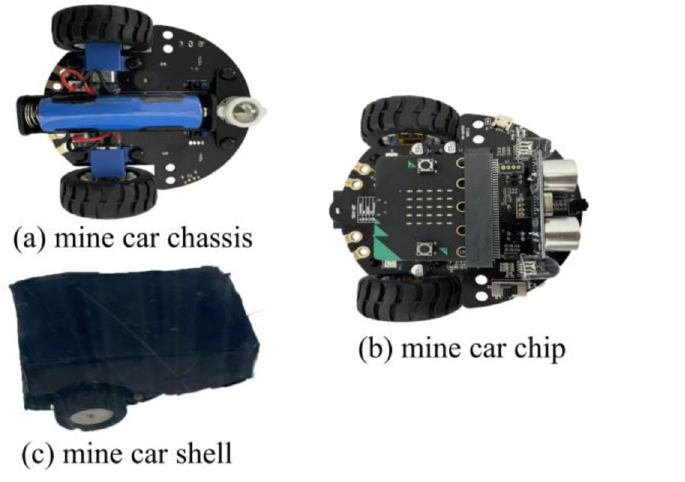
Fig 8. Detailed views of mine car.